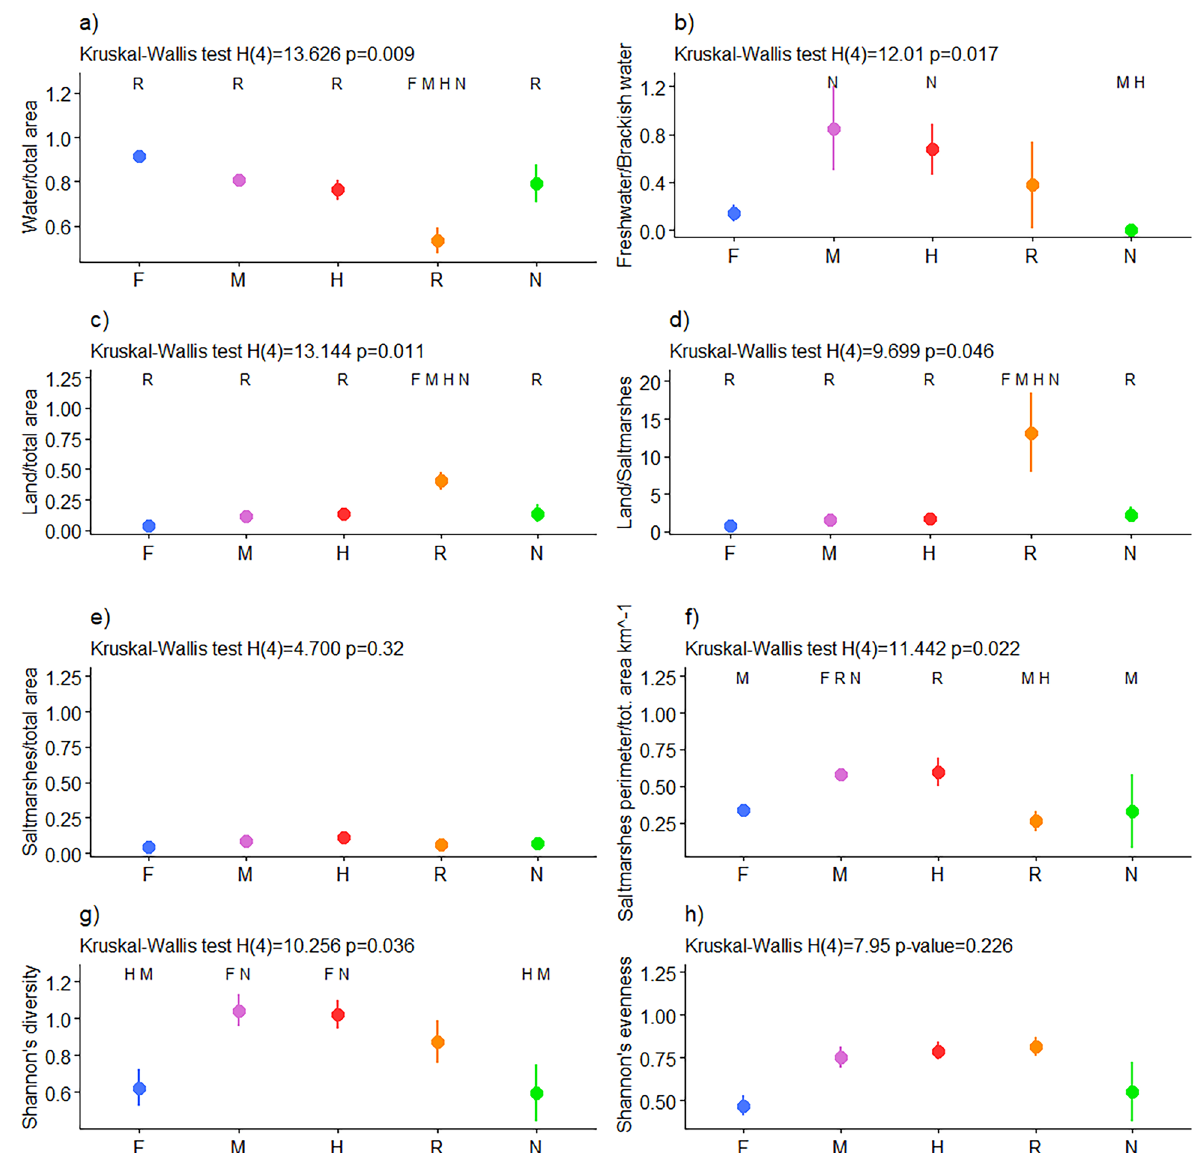
Figure 5. Landscape aggregated indicators. The dots represent the means; the bars represent each group’s standard errors of ESs indicators. In the x-axis are reported the five groups: F = fish production; M = Multiple ESs; H = Hunting; R = Recreational; N = Not managed. The letters on the top of the plots indicate the group(s) to which the group is significantly different, at 95% confidence level. Panel ( a ) shows ratio between water covered area and total area of the valle da pesca; ( b ) shows ratio between freshwater covered area and brackish water covered area; ( c ) shows ratio between land area and total area of the valle da pesca; ( d ) shows ratio between land area and saltmarshes area; ( e ) shows ratio between saltmarshes area and total area of the valle da pesca (km −1 ); ( f ) shows ratio between saltmarshes perimeter and saltmarshes area; ( g ) shows landscape Shannon’s diversity index; ( h ) shows landscape Shannon’s evenness